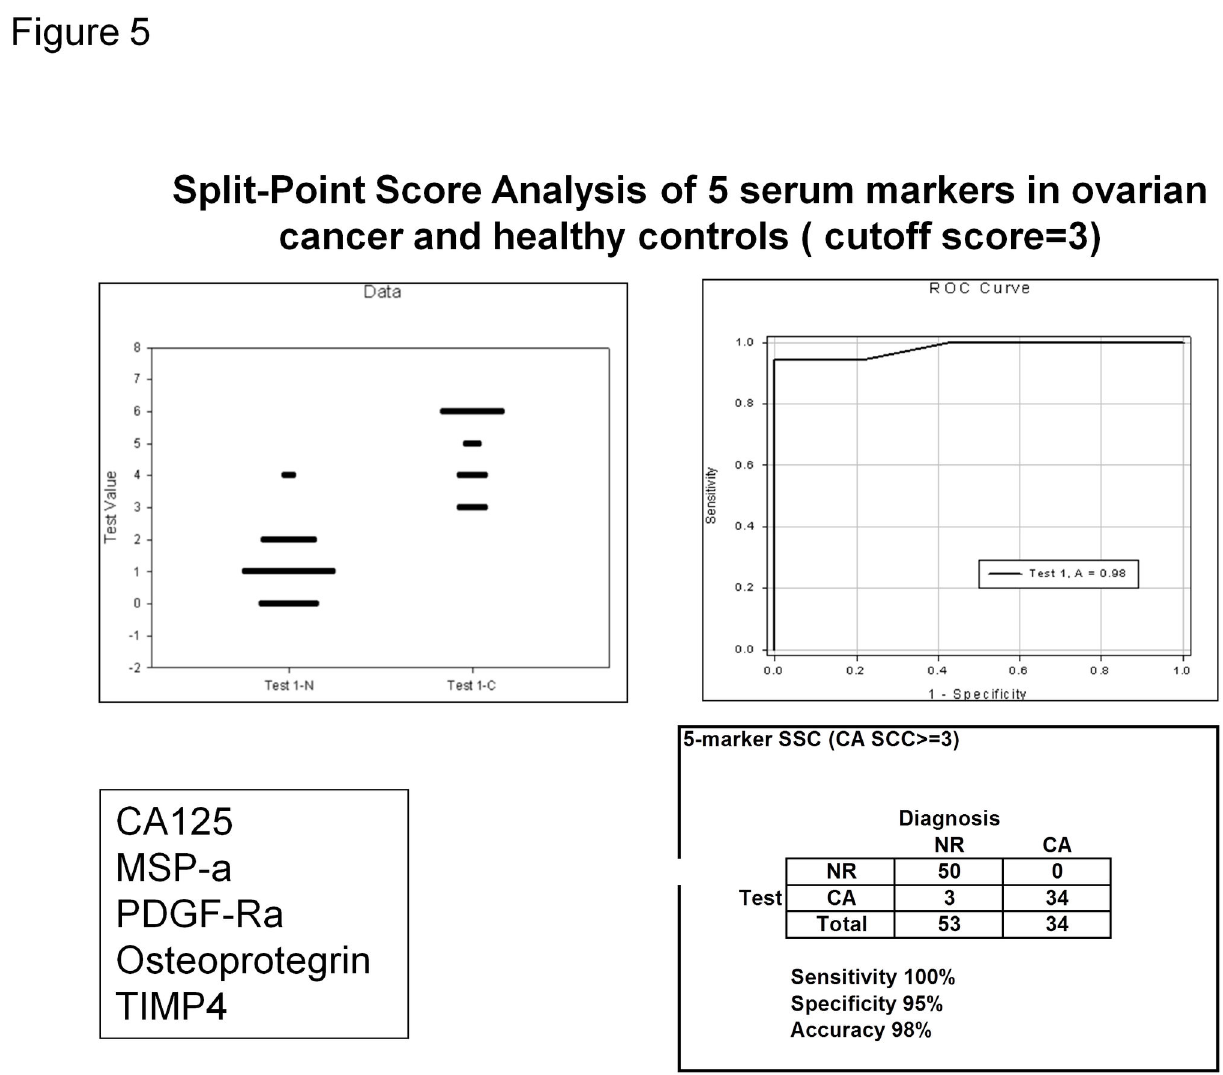
Figure 5. Split-Point Score Analysis of 5 serum markers in ovarian cancer and healthy controls. Panel A (top left): Dot histogram plot with 5-analyte split-point score classification of sera from healthy control (N) and ovarian cancer (CA). Correctly classified normal serum samples should have a score of 0 to 2, whereas samples from ovarian cancer patients should have a score of 3 to 5; Panel B (top right): The ROC curve for 5-marker panel of split-score analysis of ovarian cancer vs. healthy controls. The ROC is the curve plotted of sensitivity (true positive) against 1-specificity (false positive) values; Panel C (bottom right): Table using five-marker split-point score to classify ovarian cancer patients. A cut-off score of 3 was used. doi: